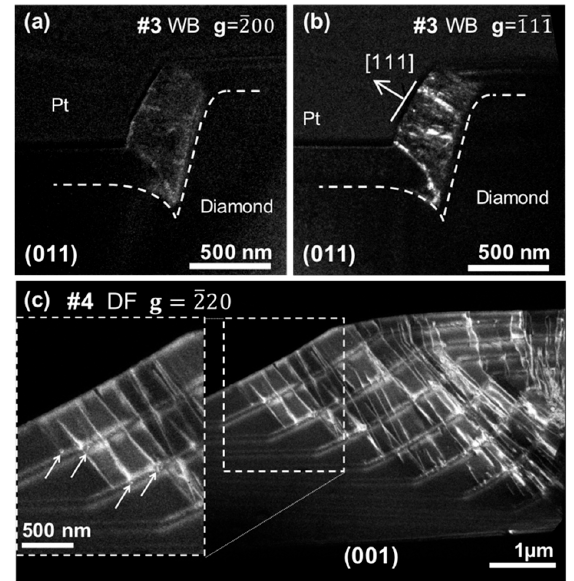
Figure 3. ( a ) Weak-beam micrograph of sample 3 with the lamella oriented along the {011} pole, recorded under two beam conditions using the 200 reflection. ( b ) Weak-beam micrograph of sample 3 with the lamella oriented along the {011} pole, recorded under two beam conditions using the 111 reflection. Lateral growth orientation is marked by a white arrow. White dashed lines mark the initial shape of the etched cylinder in both micrographs. ( c ) Dark-field micrograph of sample 4 with the lamella oriented along the {001} pole, recorded under two beam conditions using the 220 reflection. A high density of defects is observed arising from the doped layer. This is clearer in the inset displaying an enlarged image of the white dashed–framed region. White arrows in the inset marks some of the dislocations generated in the doped layers.